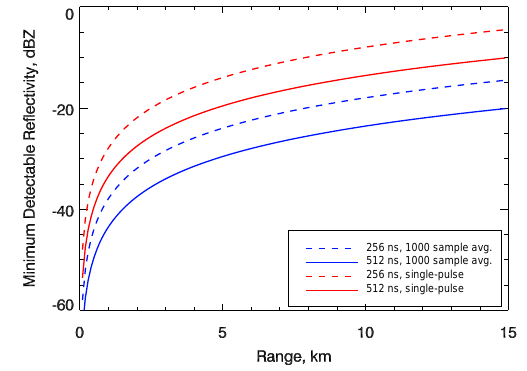
Figure 7. Sensitivity of the HCR as a function of range is shown for two different transmit pulse widths and also for single pulse and averaging over 1000